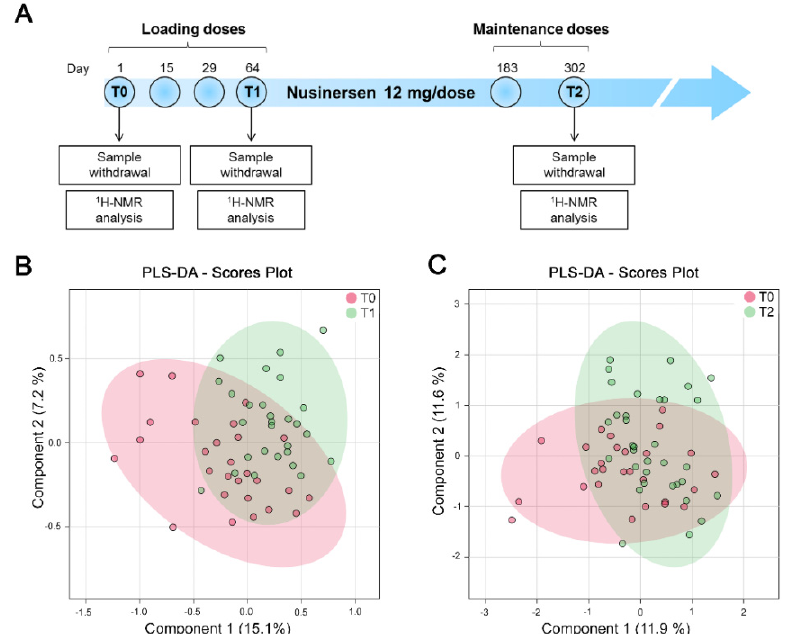
Figure 2. NMR analysis does not identify Nusinersen-dependent neurometabolomic effects in the CSF of a pooled cohort of SMA patients with different disease severity. ( A ) Schematic repre- sentation of the timeline of Nusinersen administration and CSF collection in SMA patients. ( B , C ) Multivariate statistical analysis performed on the cluster concentration matrices of the whole cohort of SMA1-3 patients collected before Nusinersen administration (T0) and at loading (T1) or maintenance phase (T2) using MetaboAnalyst 5.0. Multivariate statistical analysis produced PLS-DA score scatter plots relative to the CSF composition from SMA patients at T0 and T1 ( B ) as well as at T0 and T2 ( C ). This analysis revealed the absence of significant metabolomic differences in the CSF of the whole cohort of SMA patients either at T1 or T2, relative to untreated patients at T0. PLS-DA was evaluated using cross validation (CV) analysis. The clusters analyses are reported in the Cartesian space that is described by the main components, PC1: 15.1% and PC2: 7.2% (T0 vs. T1 clusters) ( B ) and PC1: